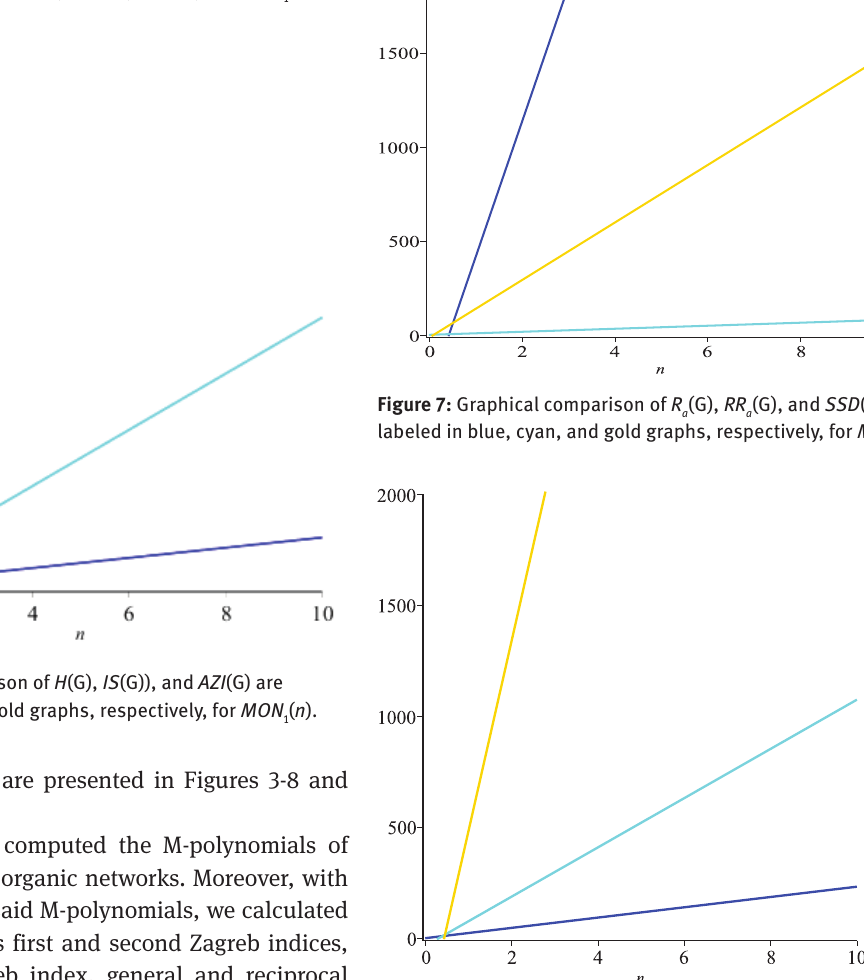
Figure 4: Graphical comparison of R labeled in blue, cyan, and gold graphs, respectively, for MON